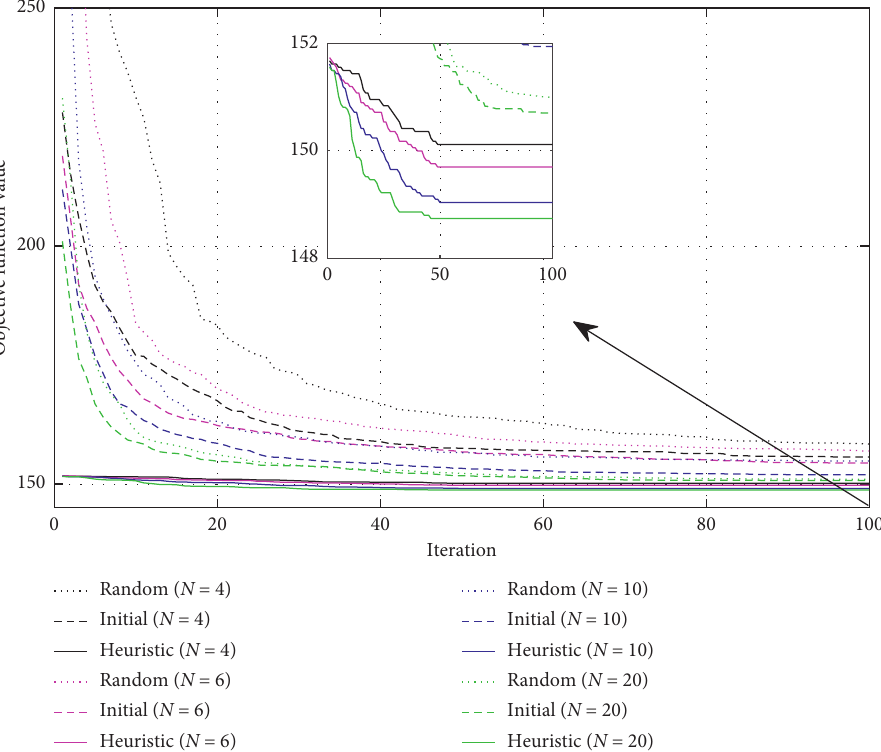
Figure 8: Mean convergence curves of three initialization methods with different population sizes for the 33-node system.